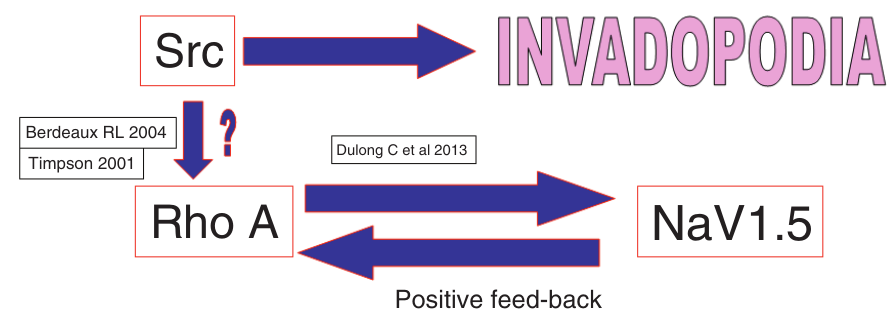
Figure 6. Tarone et al. 46 in 1985 reported the relation between the oncogenic Src and promotion of invadopodia. Berdeaux et al. 47 reported that the small molecule GTPase Rho A activity is under control of oncogenic Src and localizes in the invadopodia complex and Durlong et al. 48 (2013) showed that Rho-A regulates the expression and activity of NaV1.5 and found a positive feedback between NaV1.5 and Rho A in breast cancer cells. According to Timpson et al. 49 , cooperation between mutant p53 and oncogenic Ras activates Rho-A.